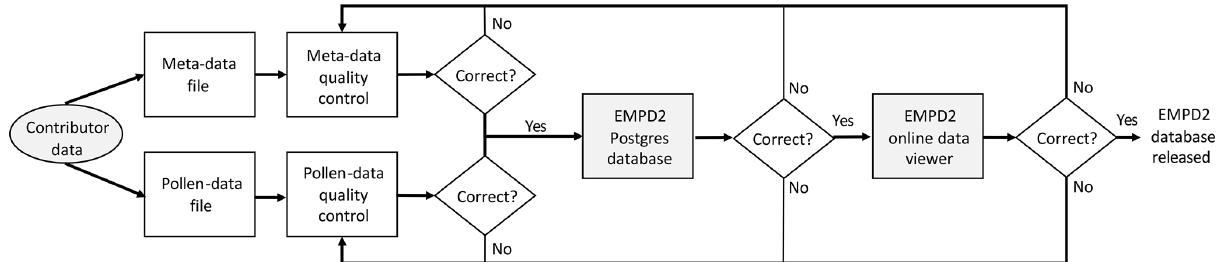
Figure 1. A flow diagram showing the data processing and quality control steps taken in constructing the EMPD2